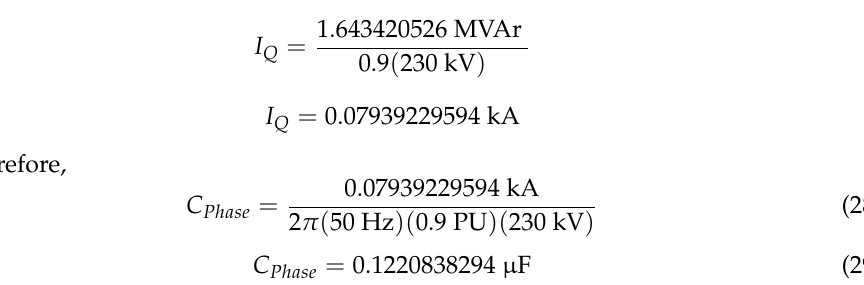
Figure 26. Monitoring and calculation logic for reactive power injection device switching logic. 4. Results Under this test, the power flow was conducted and the aerodynamic, mechanical, and electrical quantities were monitored. The operating temperature range for this wind turbine is from − 20 ℃ to 45 ℃ , the test is carried out at a temperature of 25 ℃ . For as long as the temperature is within the specified operating range, the output power of the turbine may still be tuned to the desired output. Humidity and air pressure also play a role in the value of 𝐶𝐶 𝑃𝑃 and are set to 30% and 1415 mbar. The mechanical and electrical quantities were monitored during the